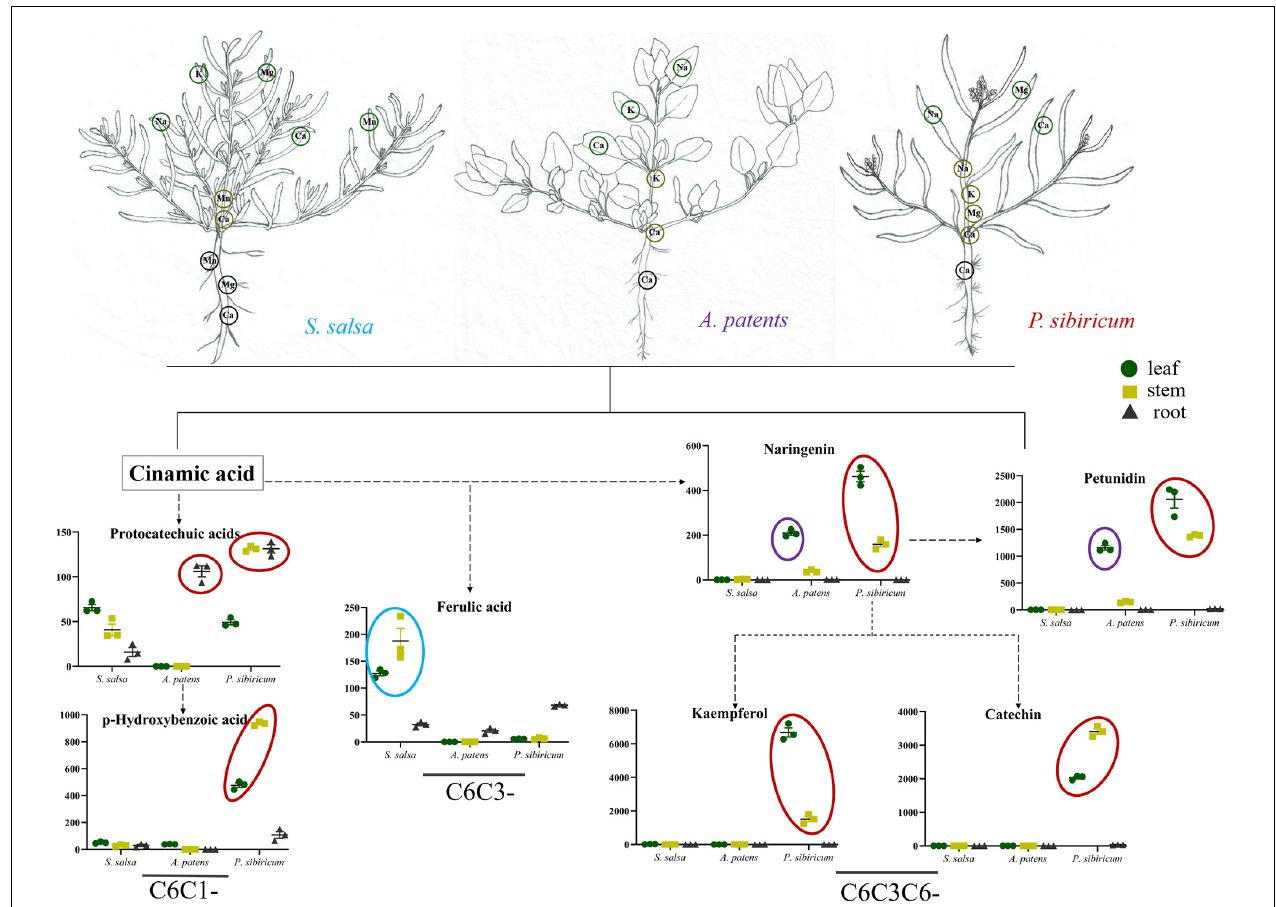
FIGURE 6 | Visualization of pathway maps of significantly different elements and phenolic metabolites in S. salsa community. Blue circle, highly expressed in S. salsa , purple circle, highly expressed in A. patents , red circle, highly expressed in P. sibiricum . The green circle, yellow circle, and black circle represent leaf, stem and root,